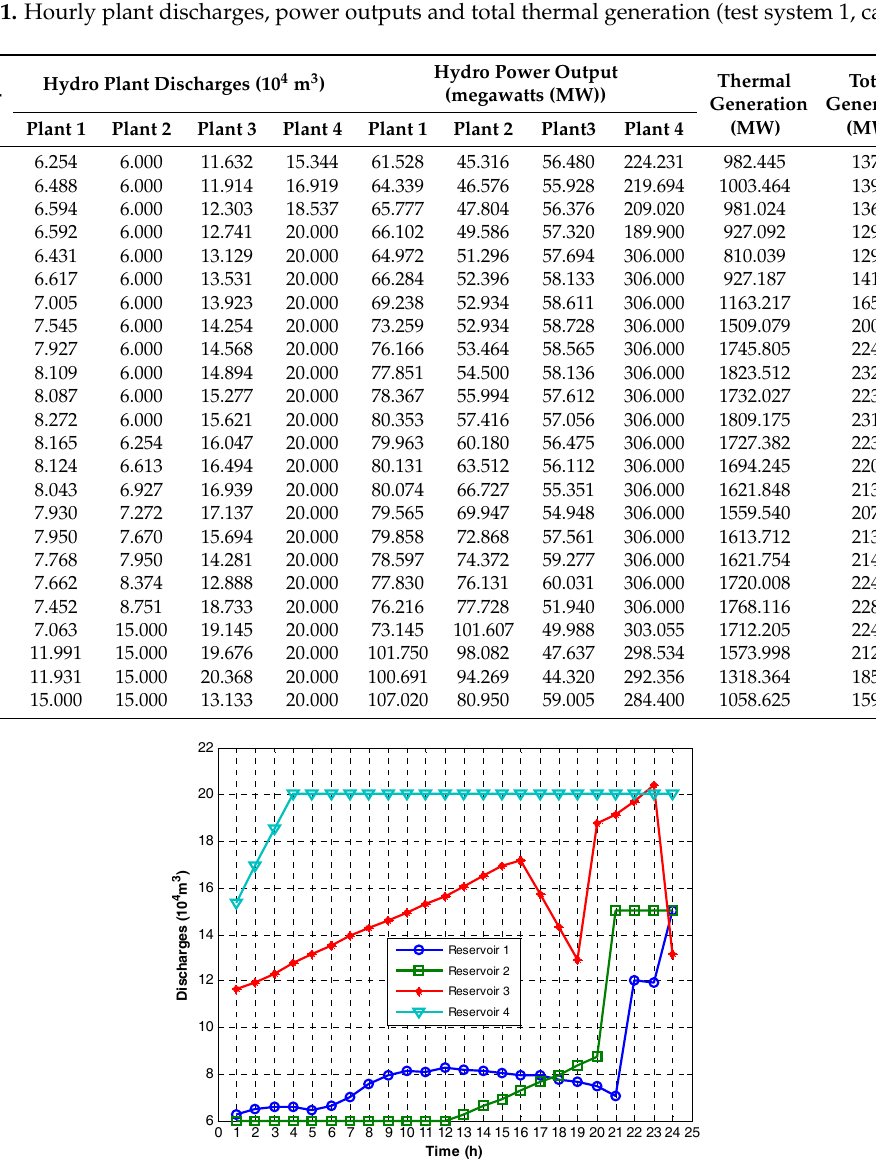
Figure 4 . Hourly hydro and thermal plant generations for test system 1, case 1. The obtained results are compared with those obtained by employing quantum-inspired evolutionary algorithm (QEA) [25], quantum-inspired evolutionary algorithm (WDA) [32], small population-based particle swarm optimization (SPSO) [33], real coded genetic algorithm (RCGA) [34], real-coded quantum-inspired evolutionary algorithm (RQEA) [25], DE [25], modified differential evolution (MDE) [33], differential real-coded quantum-inspired evolutionary algorithm (DRQEA) [25], hybrid chemical reaction optimization (HCRO)-DE [35], modified adaptive particle swarm optimization (MAPSO) [36], real-coded genetic algorithm and artificial fish swarm algorithm (RCGA-AFSA) [34], teaching learning-based optimization (TLBO) [37], smallpopulation-based particle swarm optimization (SPPSO) [33], self-organizing hierarchical particle swarm optimization technique with time-varying acceleration coefficients (SOHPSO_TVAC) [38], PSO [39], improved differential evolution (IDE) [40], fuzzy adaptive particle swarm optimization (FAPSO) [39], dynamic neighborhood learning based particle swarm optimization (DNLPSO) [15], and modified dynamic neighborhood learning based particle swarm optimization (MDNLPSO) [15], and is shown in Table 2. As it can be observed from this table, the best reported cost for this case is equal to $914,660, which is related to FAPSO [39], while total operational cost of the solution obtained by the proposed